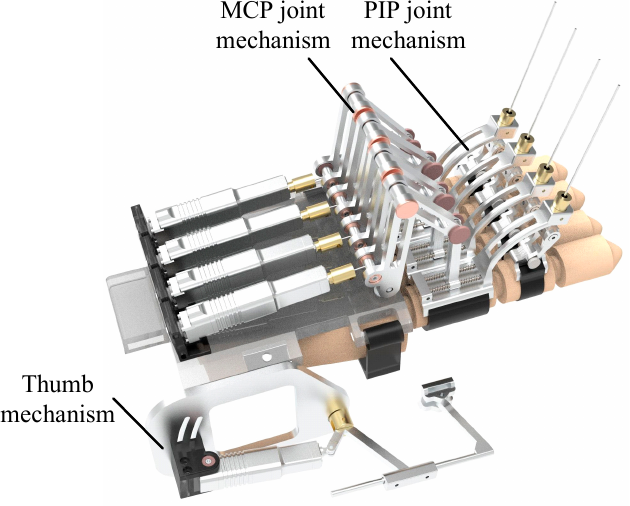
Figure 2. The model of the hand rehabilitation robot.